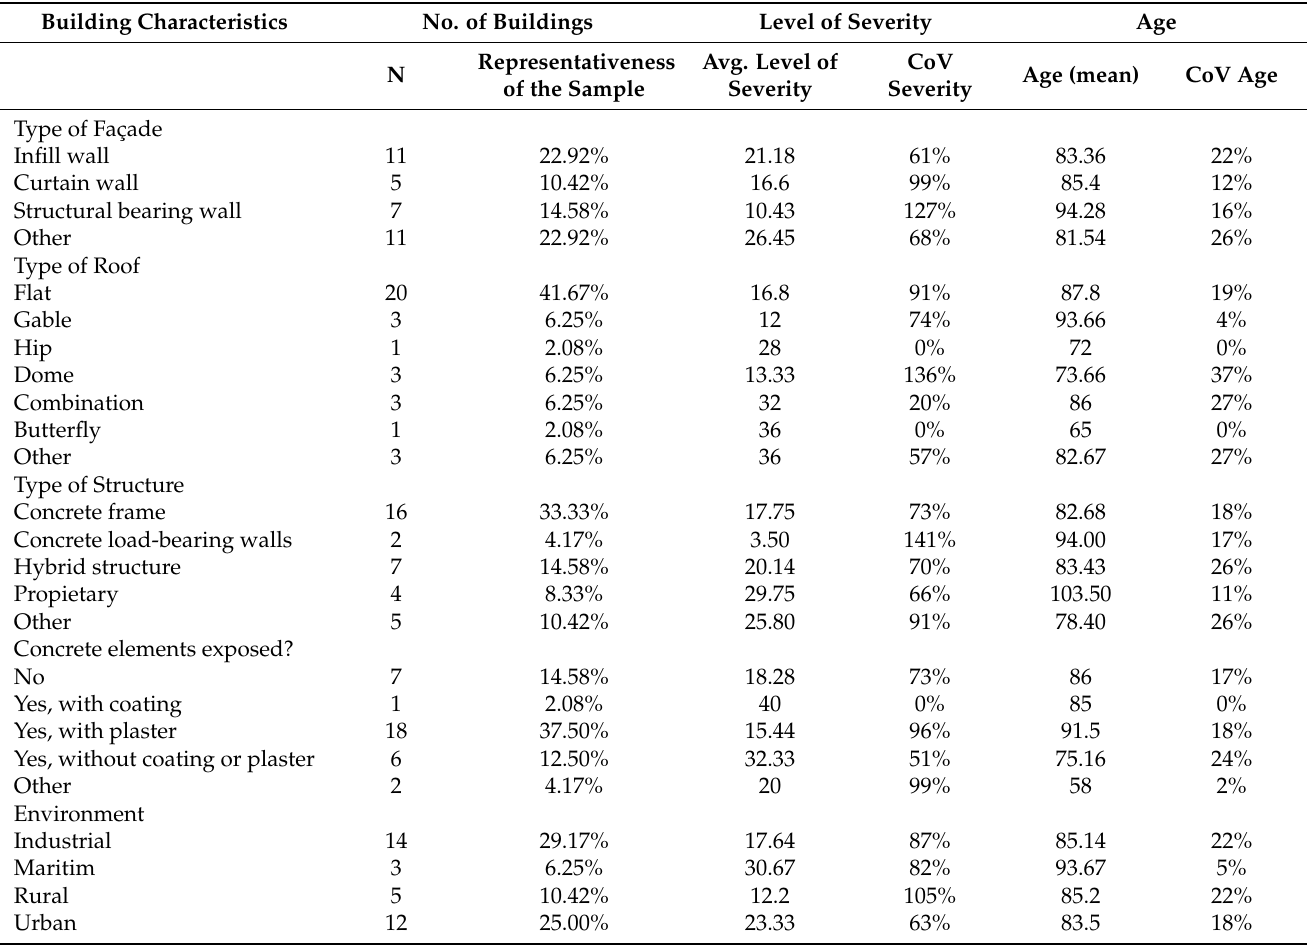
Table 3. Parameters affecting the state of conservation of historic concrete